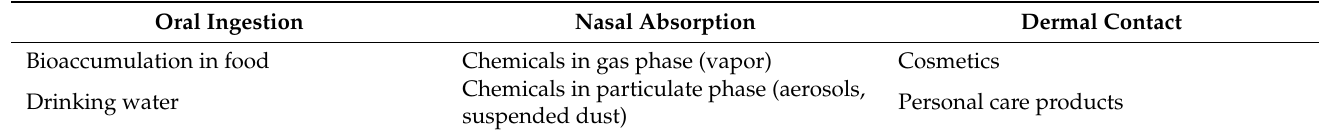
Table 2. Information about different pathways of pollutant exposure in humans